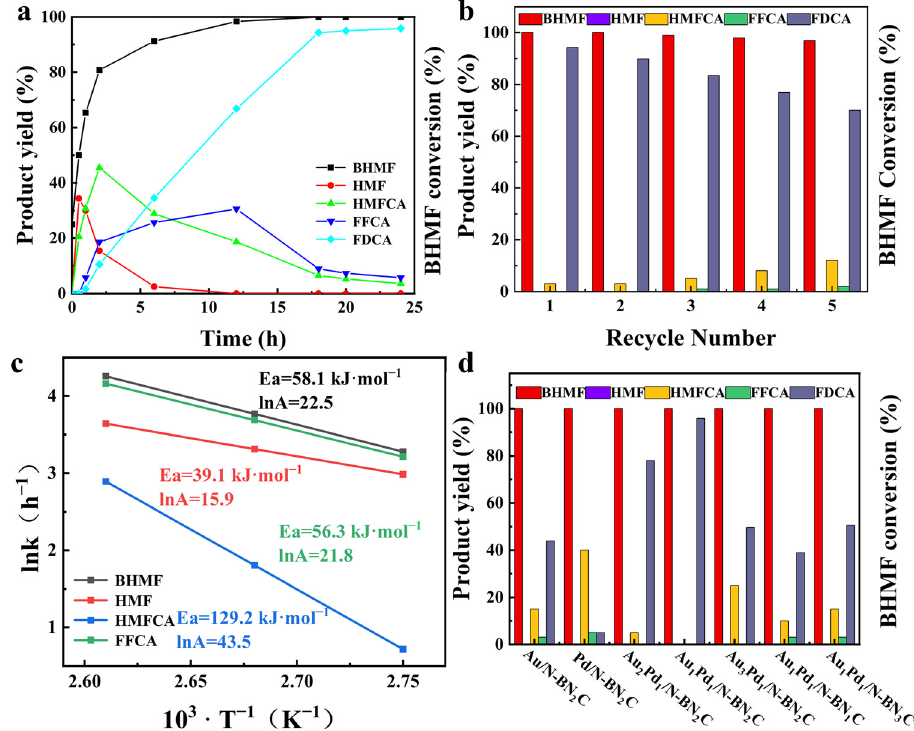
Figure 7. Effect of reaction time on the catalytic performance of the representative catalyst Au 1 Pd 1 /N-BN 2 C-800 ( a ) and a study on the circulation of the optimal Au 1 Pd 1 /N-BN 2 C nanocatalyst ( b ). Arrhenius plots of ln k based on different temperatures ( c ) and the catalytic oxidation performance of Au m Pd n /N-BN x C ( d ).